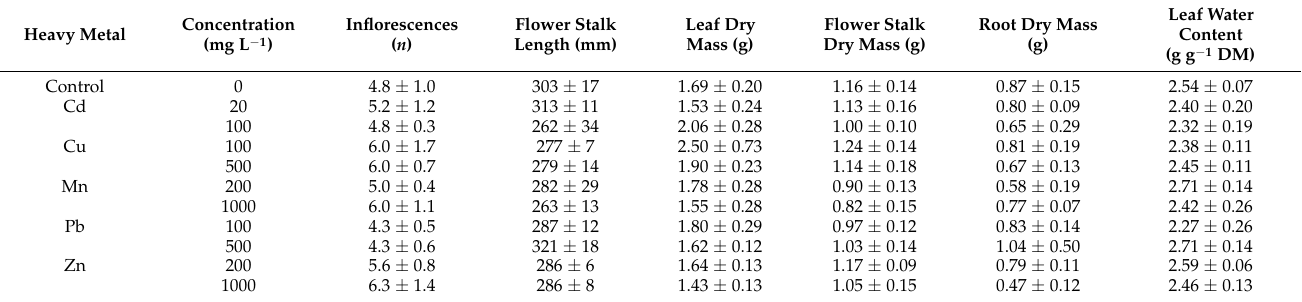
Table 5. Morphological paramaters of Armeria maritima plants (accession AM3) cultivated for 9 weeks in soil with different concentrations of heavy metals.